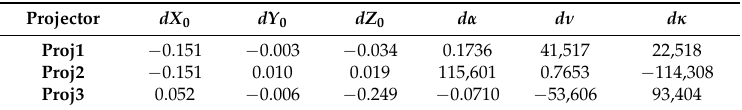
Table 9. Discrepancies between the ideal (Table 7) and the simulated exterior orientation of projectors with approximate 3D coordinates (units of translations in (m), angles in